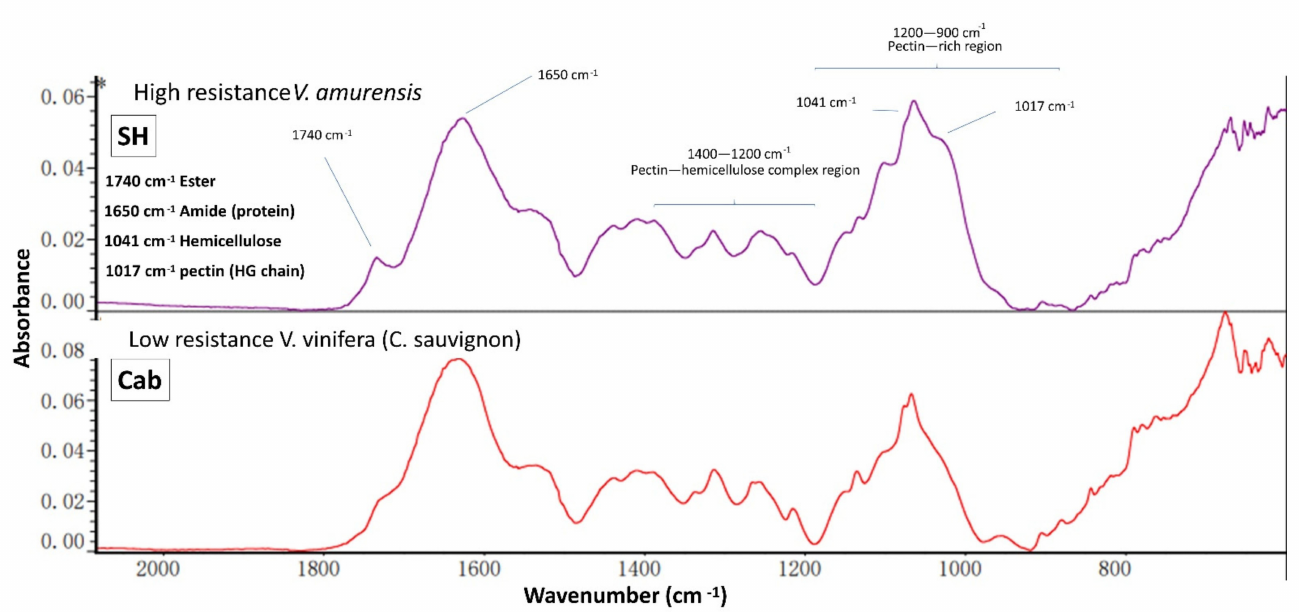
Figure 6. The monosaccharide composition of AIR sourced from grapevine leaves. The composition is expressed in relative mol% of seven main monosaccharides present in grapevine leaf cell wall. Ara: arabinose; Rha: rhamnose; Xyl: xylose; GalA: galacturonic acid; Man: mannose; Gal: galactose; Glc: glucose. Error bars represent the standard derivation of the mean value of three biological repeat.